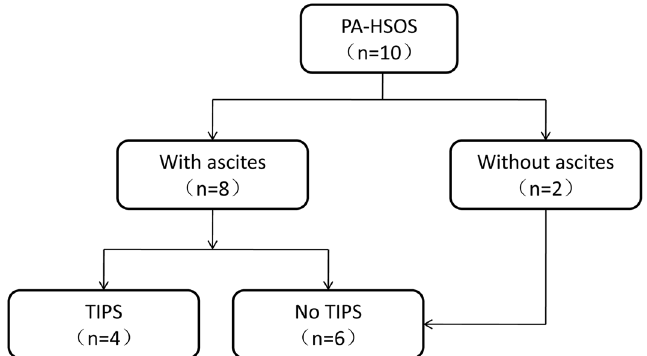
Figure 1. Flow chart of the 10